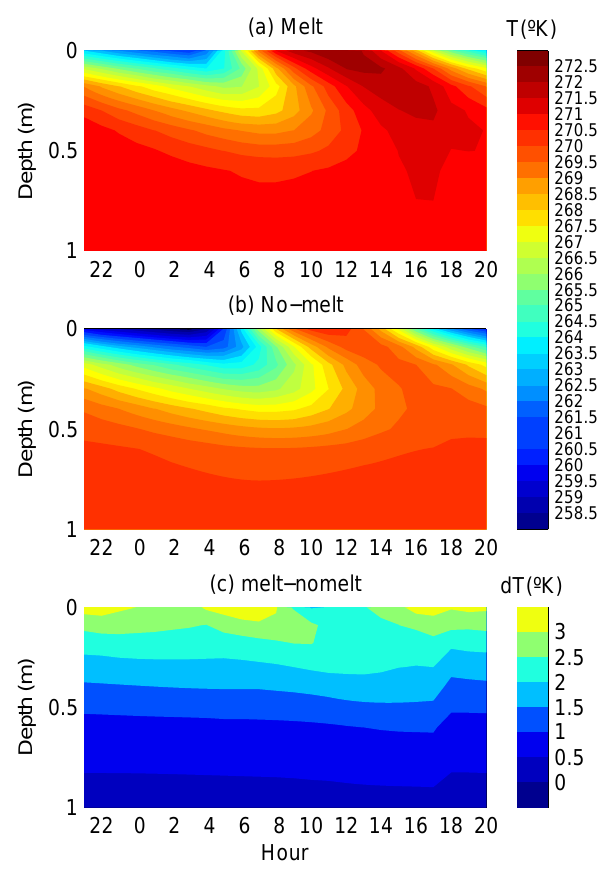
Fig. 7. Mean diurnal cycles of surface and subsurface temperatures for (a) days with melting; (b) summer days without melting; (c) melt minus non-melt